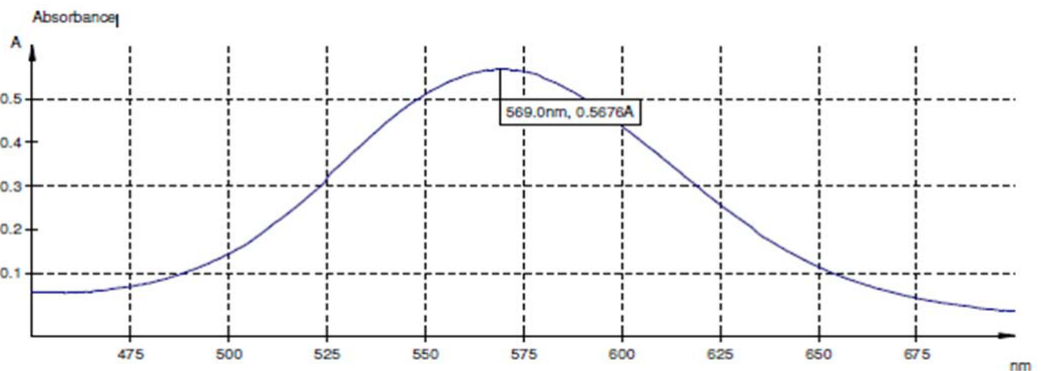
Fig. 3. UV spectrum of the reference solution